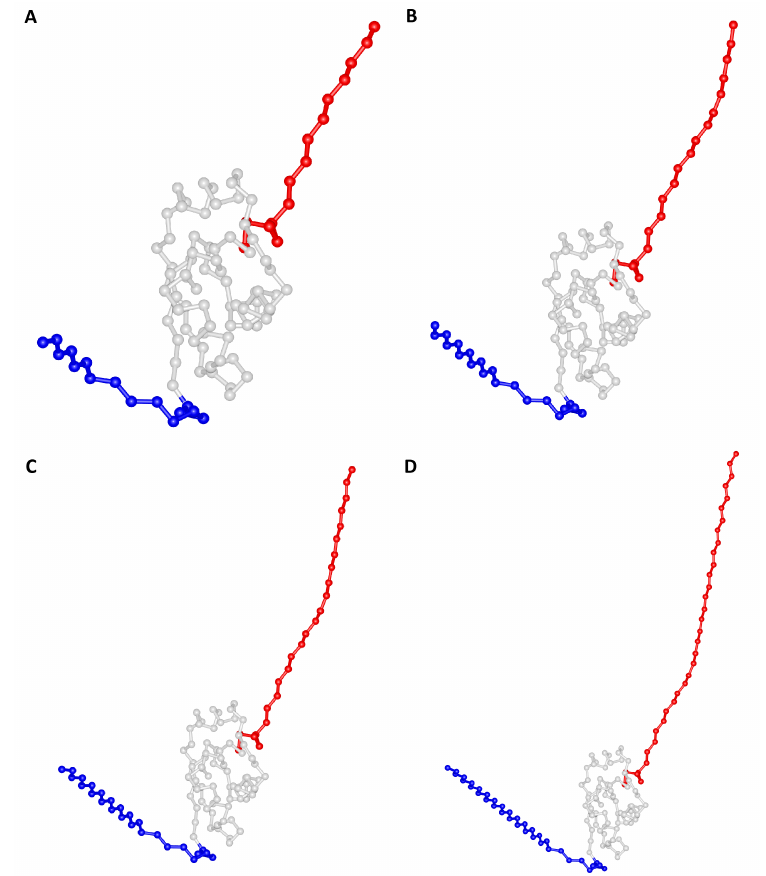
Figure 5. MJ0366 with ( A ) 5 alanines added to each tail resulting in N and C tails with 15 residues (N15C15), ( B ) 10 alanines added to each tail resulting in N and C tails with 20 residues (N20C20), ( C ) 15 alanines added to each tail resulting in N and C tails with 25 residues (N25C25) and ( D ) 25 alanines added to each tail resulting in N and C tails with 35 residues (N35C35); residues in the N-tail are colored blue, residues in the knotted core are colored grey, and residues in the C-tail are colored